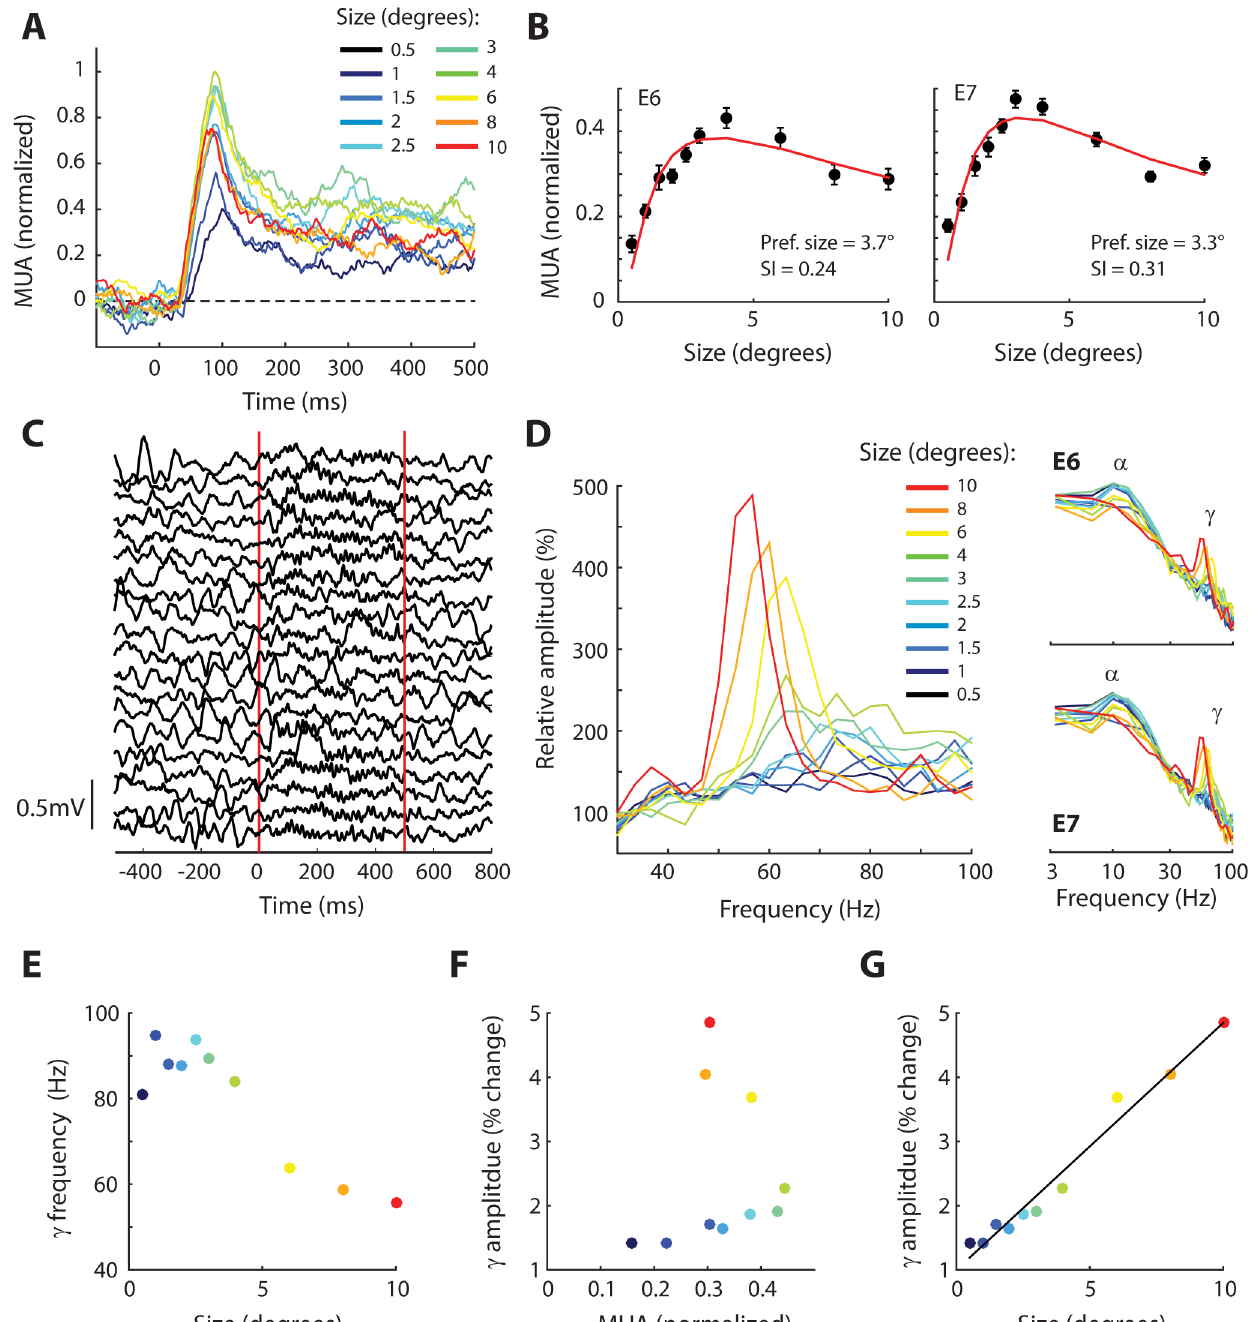
Fig 5. Size tuning of MUA and LFP. (A) MUA responses at E7 evoked by drifting gratings of various sizes. The peak response increases up to sizes around 3° – 4° and activity is suppressed at larger sizes. (B) The average response between 0 – 500 ms at each size for E6 and E7. Error-bars show +/- 1 S.E.M. The red line is the best fit of the ratio-of-Gaussians model. (C) The traces show the raw LFP from 20 trials from E7. The red vertical lines mark the onset and offset of the stimulus (a 10° diameter grating). Note the low-frequency oscillations before the appearance of the stimulus, which are replaced with high-frequency gamma oscillations after stimulus onset. (D) The relative increase in the amplitude spectrum in the gamma range as function of stimulus size averaged across E6 and E7 (compared to a pre-stimulus baseline). The non-normalized (log) amplitude spectra for E6 and E7 are shown on the right. (E) Center frequency of the gamma peak, as estimated by fitting a Gaussian function. The colors of the dots indicate the size of the grating; conventions as in panel D. (F) Increase in gamma-band amplitude as a function of the MUA response. Note the absence of a clear relationship. (G) Dependence of the change in gamma amplitude on stimulus size. There was a strong correlation (r = 0.98, p < 0.001). Data is available from